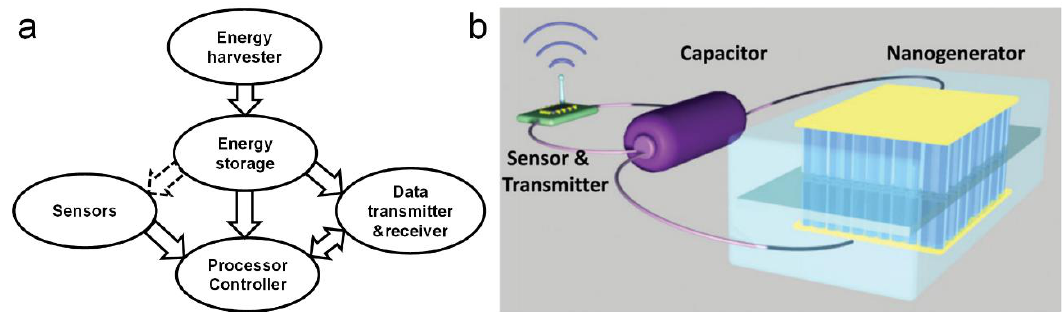
Figure 1. The schematic diagram of the integrated self-powered system. ( a ) An integrated system can be divided into five modules: energy harvester, energy storage, sensors, data processor and controller, and data transmitter and receiver. ( b ) Prototype of an integrated self-powered system using a nanogenerator (NG) as the energy harvester. Reproduced with permission [6]. Copyright 2012, John Wiley & Sons.